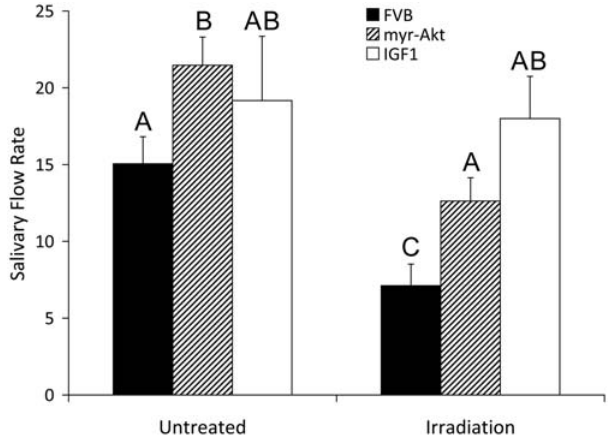
Figure 4. Preservation of salivary flow rates 30 days after single c -radiation exposure by myr-Akt1 or injection with IGF1. Four-week old female FVB, myr-Akt1 and FVB mice injected with 5 m g recombinant IGF1 were exposed to 1 Gy c -radiation. IGF1 injections were performed immediately prior to radiation exposure as described in Figure 3. Thirty days after exposure to c -radiation total saliva was collected following carbachol injection as described in Figure 2. Statistical analysis was performed using multiple comparison testing in the SAS system. Results shown are from ten irradiated FVB mice, ten irradiated myr-Akt1 mice and eight IGF1 plus irradiation mice and graphed using the averages and SEM from all mice. Treatment groups with the same letters are not significantly different from each